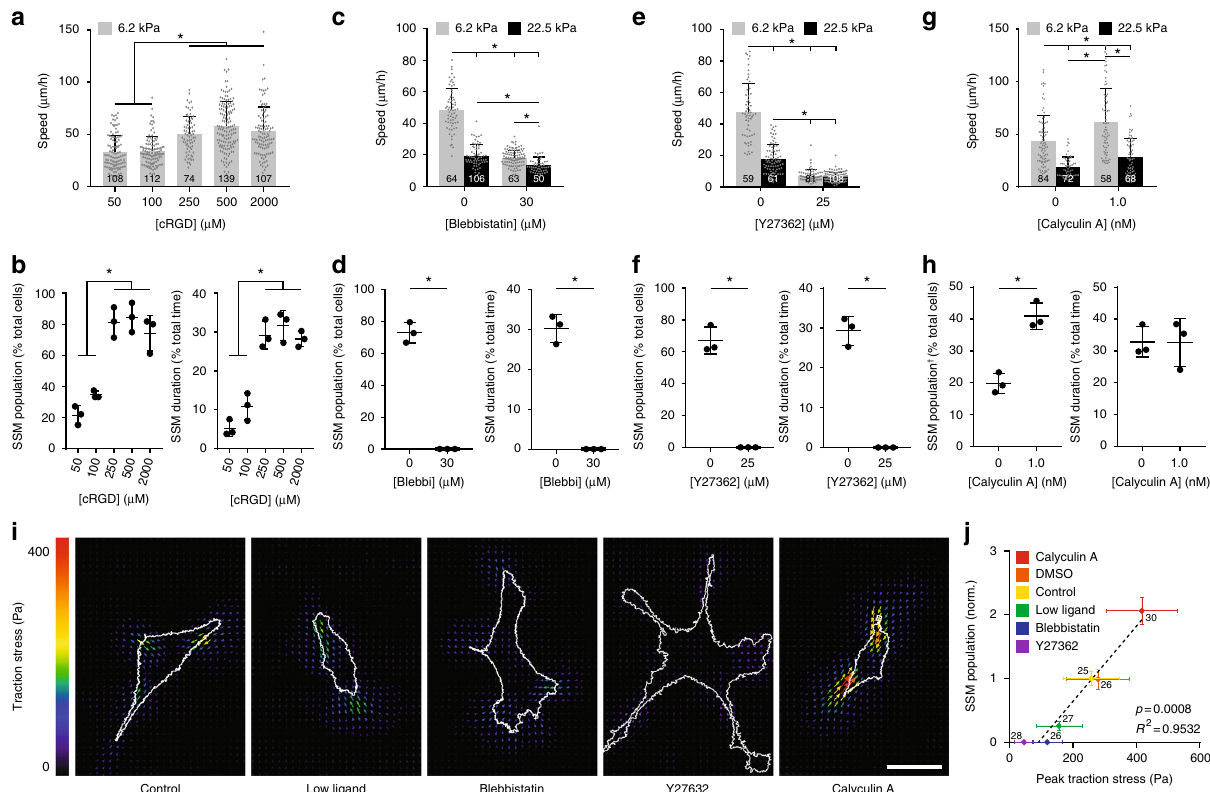
Fig. 5 Slingshot migration (SSM) requires matrix adhesion and actomyosin contractility. a , b Migration speed, SSM population (% of cell population undergoing one or more SSM event), and SSM duration (% of tracked time of entire population spent in some phase of SSM) in aligned, intermediate stiffness (6.2 kPa) matrices with a range of cRGD functionalization. n = number of cells per group as indicated within each bar ( a ); n = 3 fi elds of view with each fi eld of view containing 10 cells ( b ). c , e , g Migration speed in aligned, intermediate (6.2 kPa) and high (22.5 kPa) stiffness matrices treated with blebbistatin, Y27632, or calyculin A ( n = number of cells per group as indicated within each bar). d , f , h SSM population and slingshot duration in aligned, intermediate stiffness (6.2 kPa) matrices treated with blebbistatin, Y27632, or calyculin A ( n = 3 fi elds of view with each fi eld of view containing 10 cells). Migration speed, SSM population, and SSM duration were quanti fi ed over a 6 h time course for cRGD, blebbistatin, and Y27 studies, and quanti fi ed over a 1 h time course for calyculin A studies (indicated with † ). i Representative traction stress maps of NIH3T3s on 7.9 kPa polyacrylamide hydrogels subjected to equivalent perturbations as in a – h (scale bar: 50 μ m). j Slingshot population (normalized to control) as a function of peak traction stress determined by traction force microscopy. Dashed line indicates linear correlation with indicated R 2 and p -value. n = number of cells per group as indicated beside each data point. All data presented as mean ± s.d.; * indicates a statistically signi fi cant comparison with p < 0.05 ( a – c , e , g : one-way analysis of variance; d , f , h : two-tailed Student ’ s t -test; j : linear